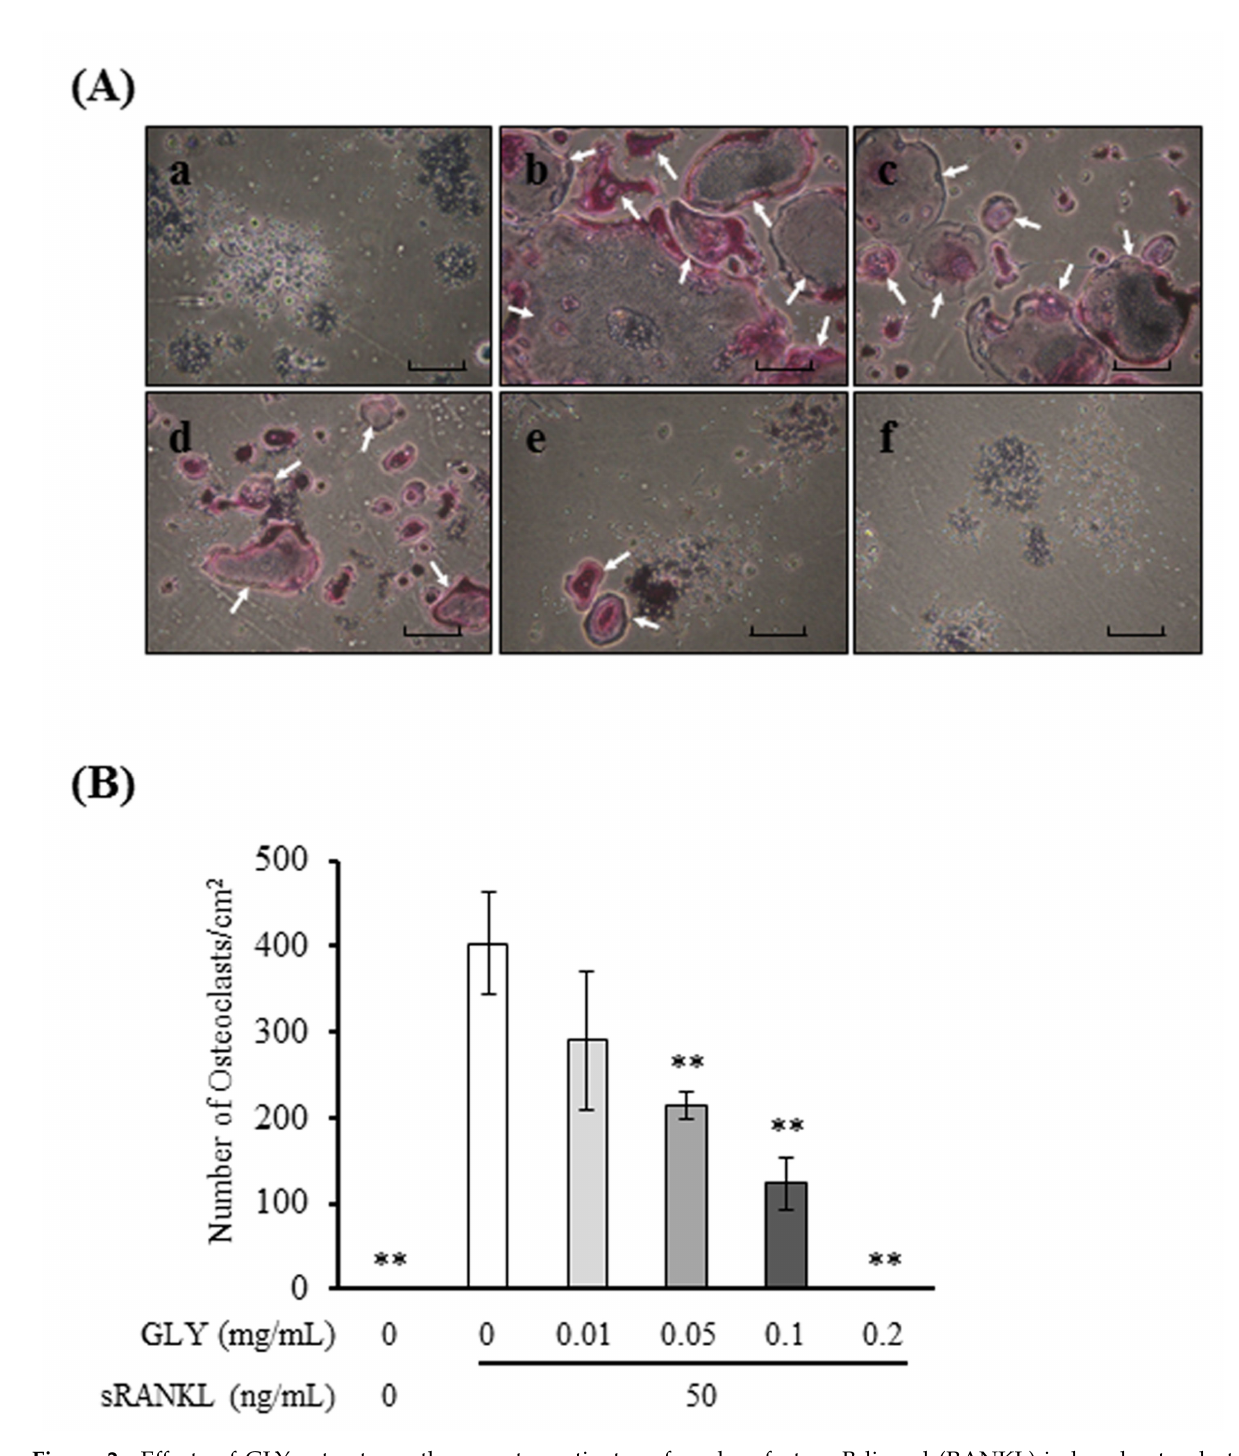
Figure 2. Effects of GLY extracts on the receptor activator of nuclear factor- κ B ligand (RANKL)-induced osteoclast differentiation. ( A ) Microscopic observations for tartrate-resistant acid phosphatase (TRAP) staining of osteoclast-like positive multinucleated cells (MNCs) derived from soluble RANKL (sRANKL)-treated RAW264.7 cells in the absence or presence of various concentrations of the GLY extracts for five days. ( a ) no-treated with sRANKL and absences of GLY extracts; ( b ) absence of GLY extracts; ( c ) 0.01mg/mL of GLY extracts; ( d ) 0.05mg/mL of GLY extracts; ( e ) 0.1mg/mL of GLY extracts; ( f ) 0.2mg/mL of GLY extracts. Magnification x100, the arrowheads indicate TRAP-positive osteoclasts. Scale bars represent 300 µ m. ( B ) Quantitative analysis of TRAP-positive MNCs with three or more nuclei in each well. Data are presented as the mean ± SD. ** p < 0.01 compared with the sRANKL treatment in the absence of GLY extracts. These procedures were repeated three times by using triplicate RAW264.7 cell